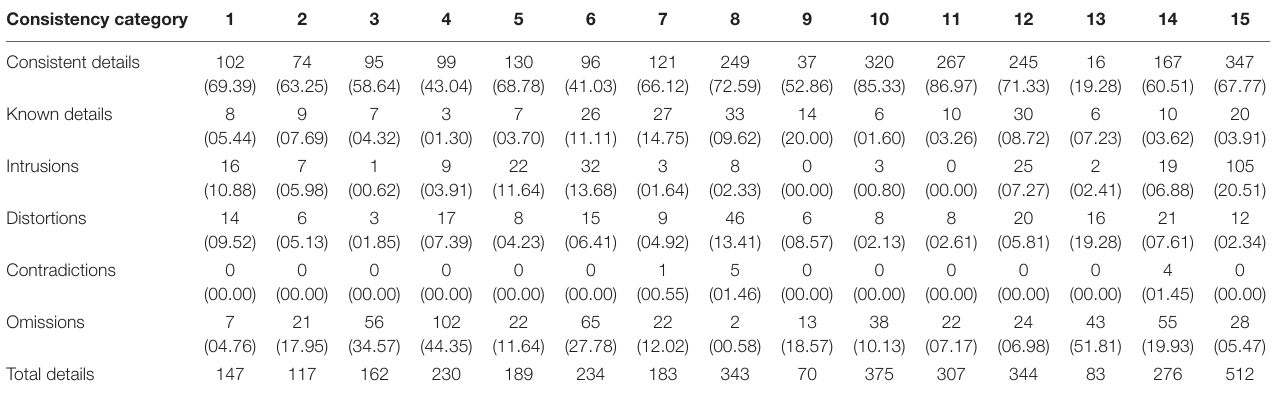
TABLE 1 | Number of details per interview transcript and hand-written statement pair across coded consistency category (% of transcript); illustrates discrepancy across each of the fifteen statements. Consistency category